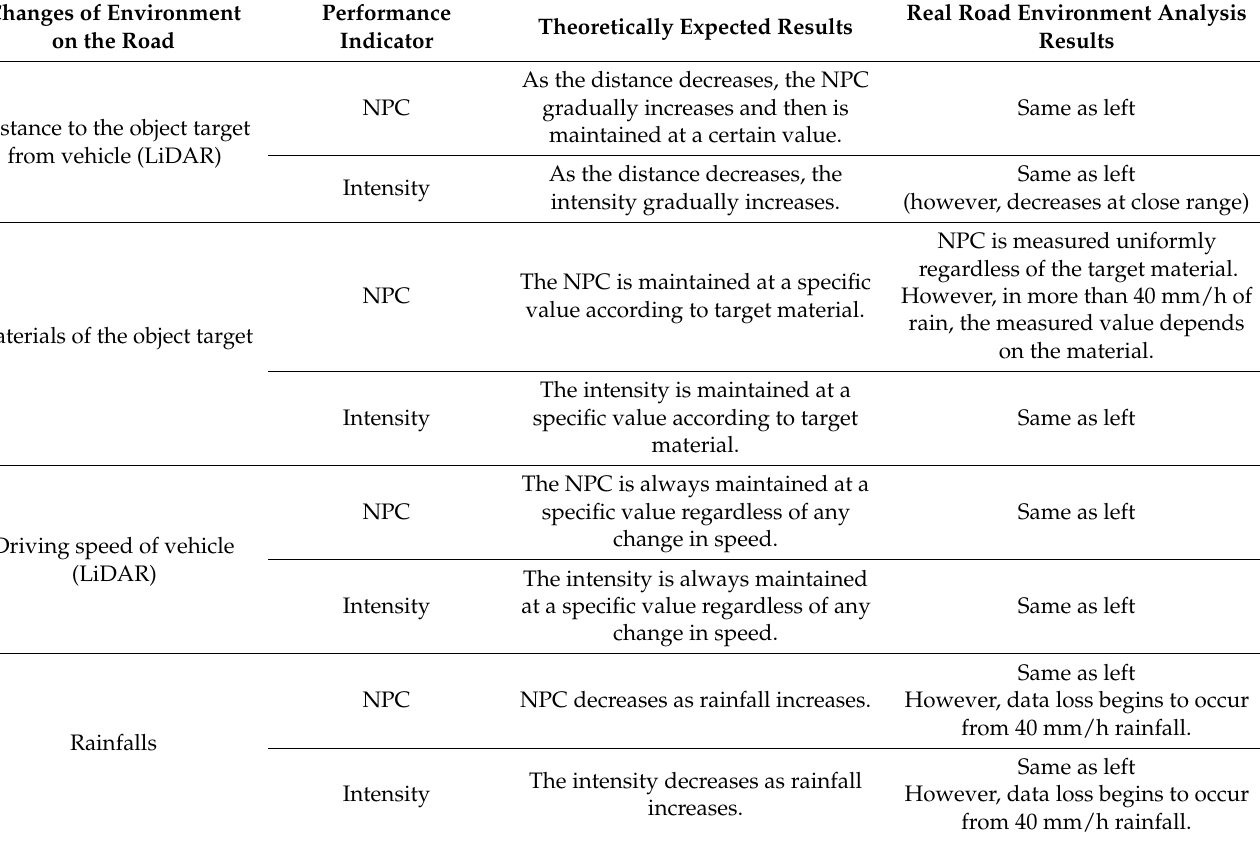
Table 9. Summary of the performance validation results of the various test items for performance verification of LiDAR. Real Road Environment Analysis Changes of Environment Performance Theoretically Expected Results on the Road